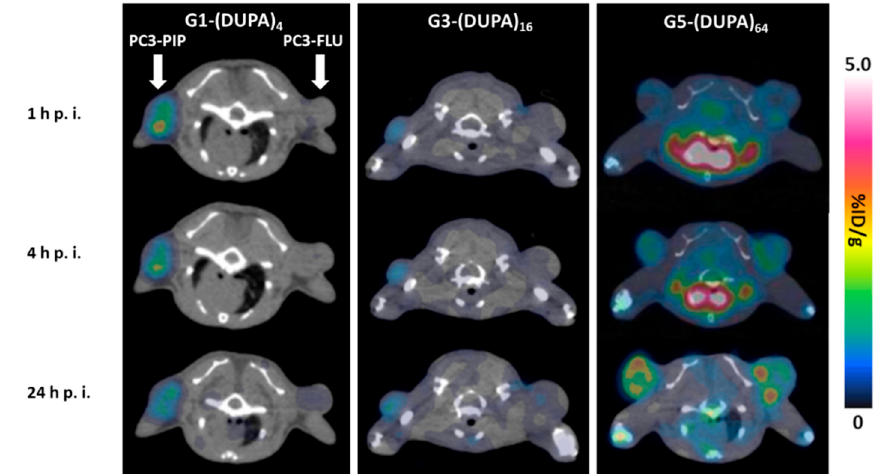
Figure 5. Representative trans-axial PET-CT images of the 64 Cu-labeled dendrimers in SCID mice bearing PSMA + PC3-PIP xenografts on the left shoulder and PSMA - PC3-FLU xenografts on the right shoulder at 1, 4, and 24 h p.i. ( n = 3 for G1-(DUPA) 4 and G5-(DUPA) 64 ; n = 4 for G3-(DUPA) 16 ).